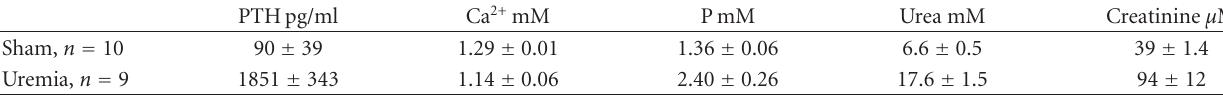
Table 2: Plasma parameters of the sham and uremic group of